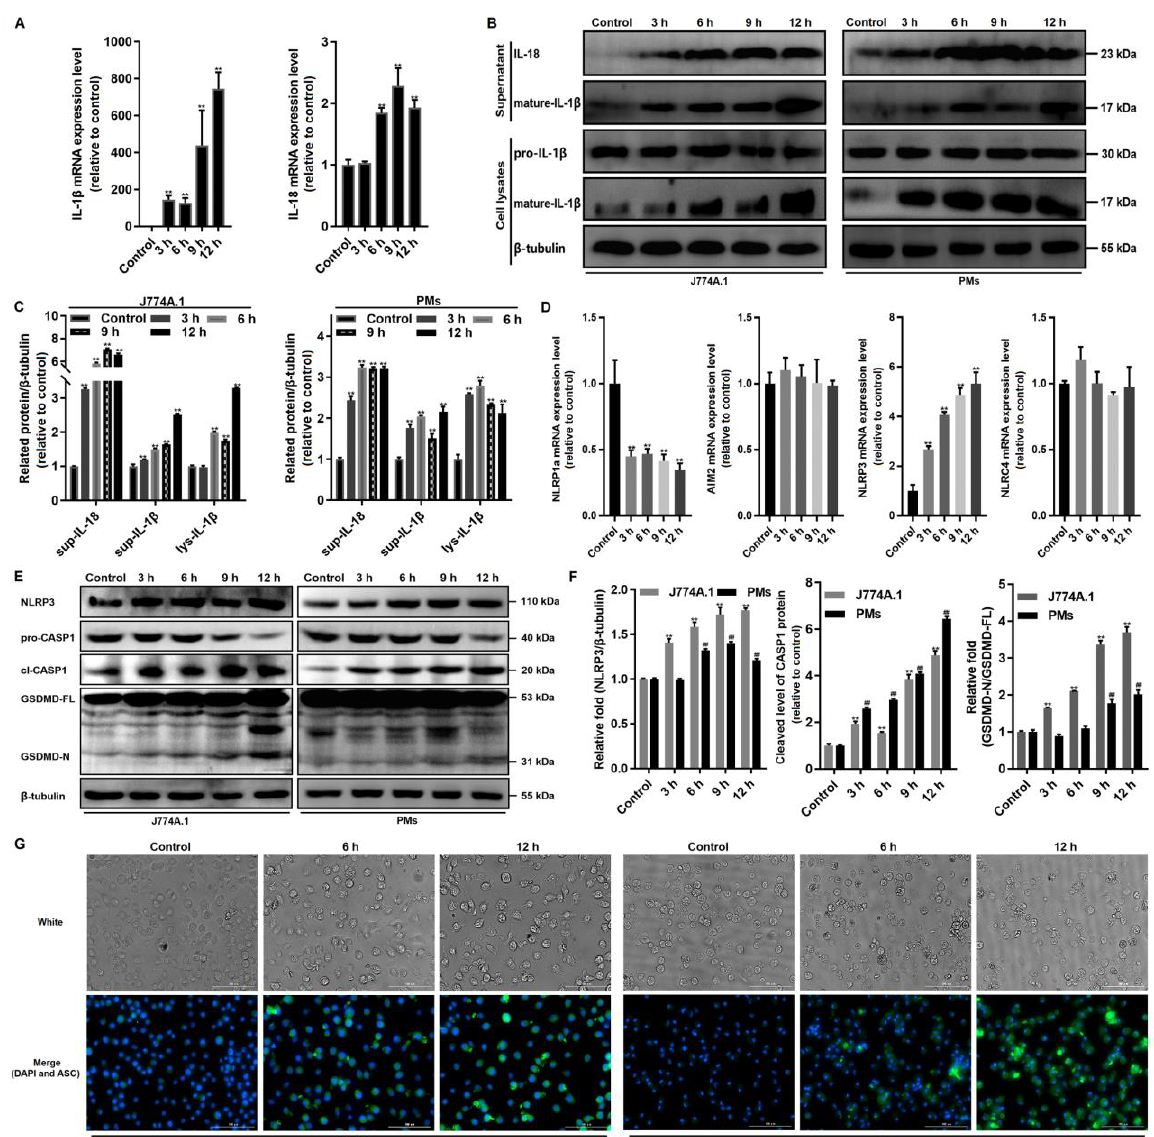
Figure 2. Giardia -induced NLRP3/CASP1/GSDMD-mediated macrophage pyroptosis. J774A.1 cells or PMs were treated with trophozoites at a ratio of 10 parasites/cell for the indicated time periods. ( A ) The mRNA levels of IL-1 β and IL-18 in PMs were evaluated by qPCR. ( B , C ) The protein levels of mature-IL-1 β and IL-18 were assessed by Western blot analysis. The abbreviation sup- stands for supernatant, and lys- for cell lysates. ( D ) The mRNA levels of inflammasome sensors in PMs were assessed by qPCR. ( E , F ) Representative Western blots and quantification of NLRP3, pro/cl-CASP1, and GSDMD-FL/N proteins are shown. The abbreviation GSDMD-FL stands for full-length GSDMD, and GSDMD-N for N-terminal GSDMD. ( G ) ASC protein expression was detected by immunofluorescence staining (scale bar = 100 µ m). All experiments were repeated at least three times. ( A , C , D , F ) Values are expressed as the mean ± SD (** , ## p < 0.01 as compared to controls). ( B , E , G ) Representative pictures are